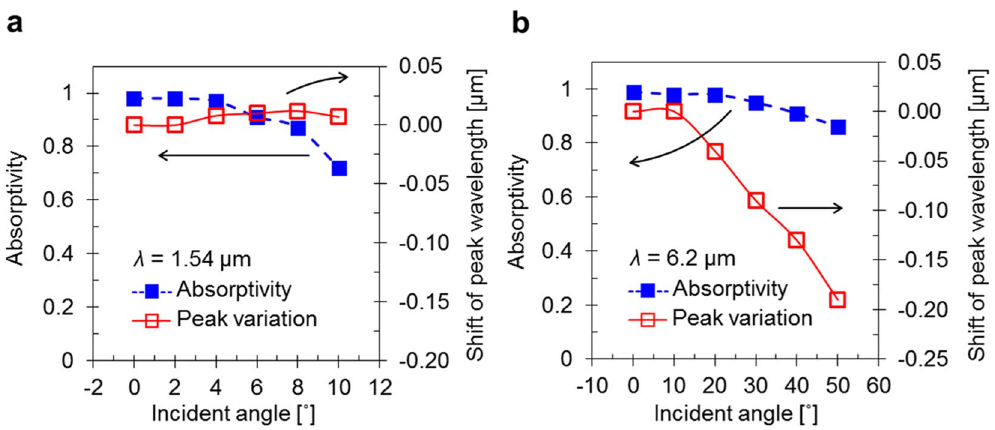
Figure 5. Incident angle sensitivity. Calculated absorptivities and wavelength shifts of the ( a ) 1.54 μ m and ( b ) 6.2 μ m MP peaks for various incident